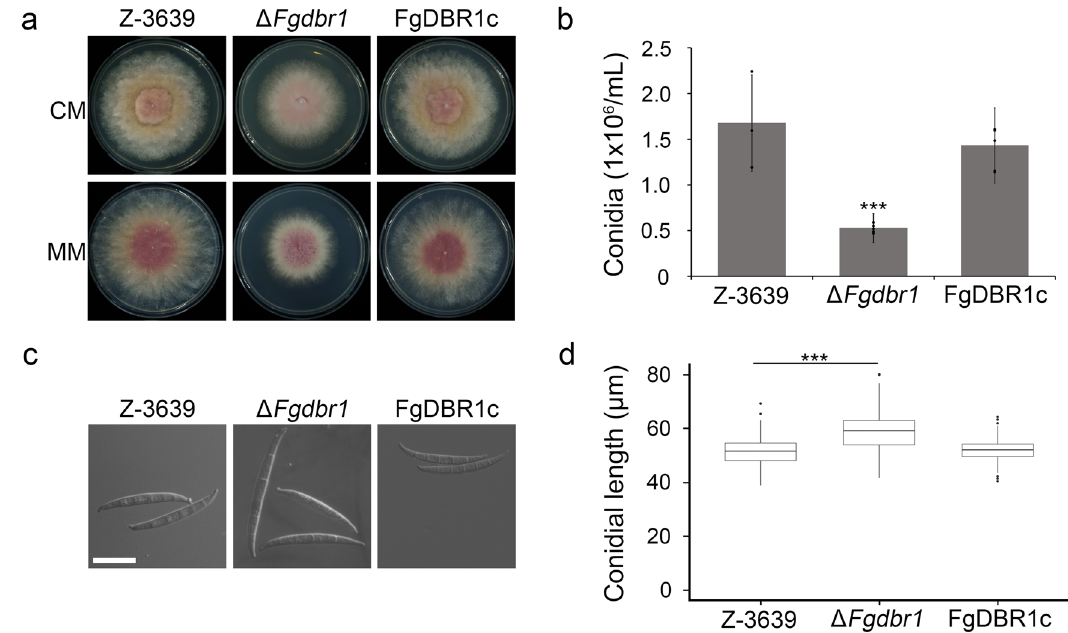
Fig. 2 Vegetative growth and conidiation of F. graminearum strains. a Mycelial growth of F. graminearum strains on complete medium (CM) and minimal medium (MM). Pictures were taken 5 days after inoculation. b Conidial production. The number of conidia generated by each strain was counted after 5 days of incubation in carboxymethyl cellulose (CMC) medium. Error bars represent standard deviations of biological replicates ( n = 3 for wild type, n = 6 for Δ Fgdbr1 and FgDBR1c). The triple asterisks indicate signi fi cant difference with p < 0.001. c Conidial morphology. Conidia were induced on yeast malt agar (YMA) for 48 h and subsequently observed by differential interference contrast (DIC) microscopy. Scale bar = 25 μ m. d Boxplot showing conidial length of each strain. Lower and upper whiskers represent 1.5 times of the lower and upper interquartile ranges (IQR), respectively, and median values were indicated by solid black lines. The length of 300 conidia induced on YMA were measured for each strain. *** p < 0.001. Table 1 Phenotypic characterization of the Δ Fgdbr1 mutant.